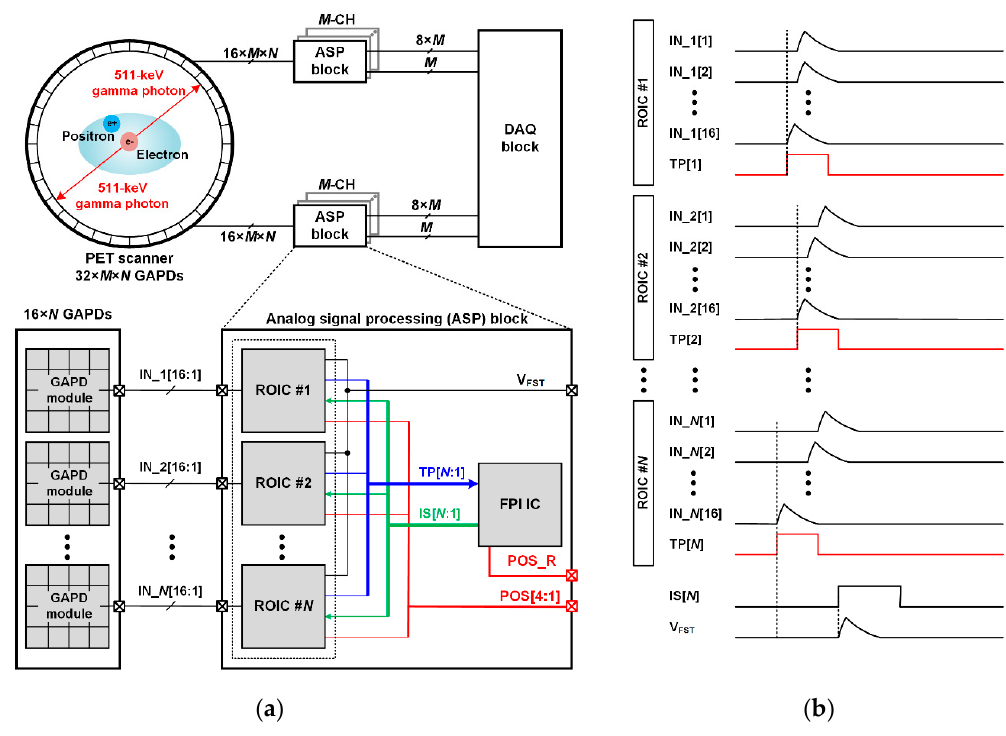
Figure 1. ( a ) Block diagram of a positron emission tomography (PET) system based on the proposed readout integrated circuit (ROIC) and ( b ) timing diagram of the analog signal processing (ASP) block.